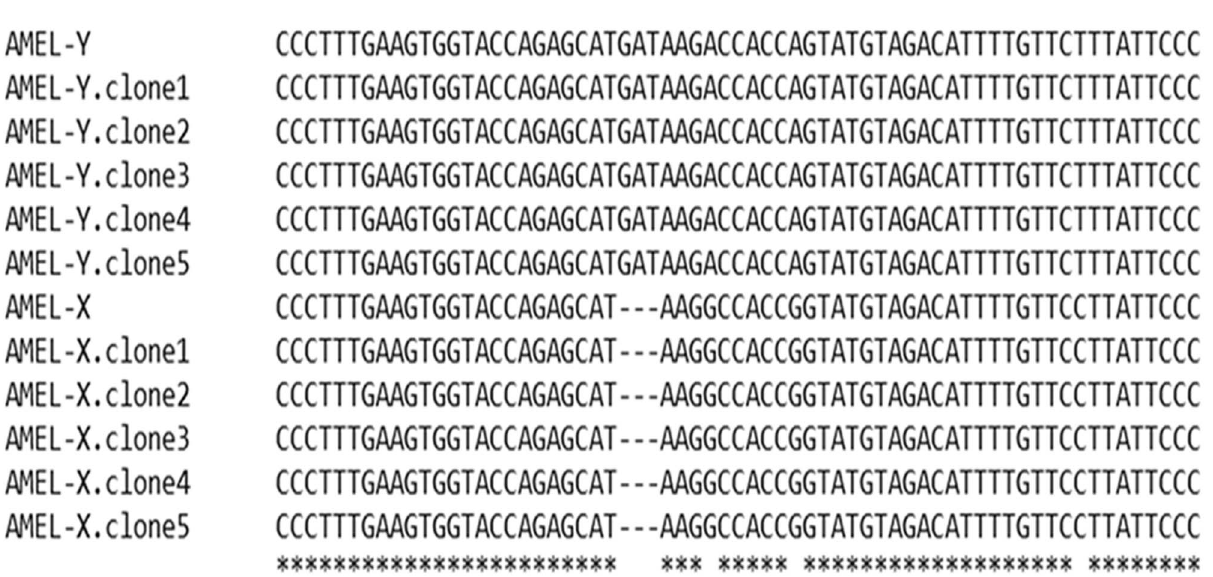
Figure 2. Confirmation of the HRM analysis by Sanger Sequencing. AMELX-allele and AMELY-allele fragment (61 and 64 bp, respectively) of positive controls were amplified by real-time PCR, cloned, and sequenced. The sequences obtained demonstrate the 3-bp deletion on the AMELX- allele.